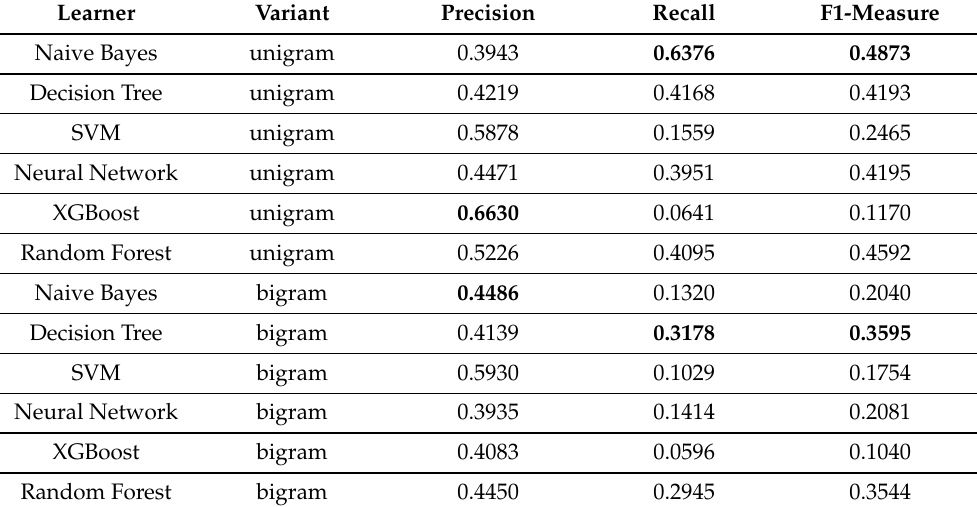
Table 2. The performances of the learners with a bag-of-words model with 500 terms for unigrams and 250 terms for bigrams. The best performance for unigrams and biagrams is marked in bold. Learner